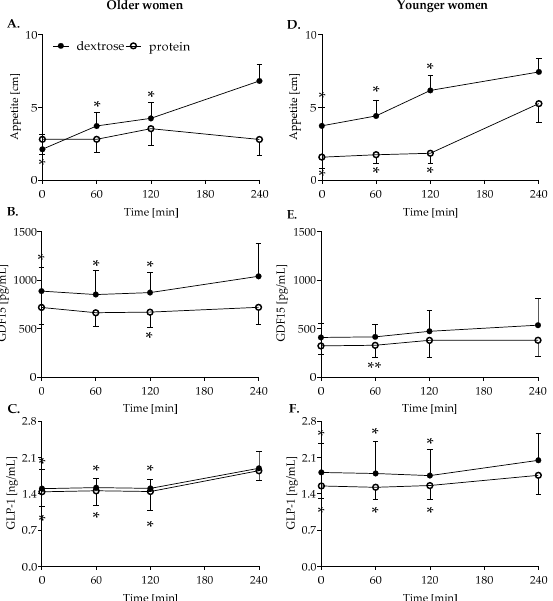
Figure 2. Postprandial appetite ( A ), GDF15 ( B ) and GLP-1 ( C ) concentrations in older and younger women (( D , E , F ), respectively) following dextrose (closed circles) or protein (open circles) ingestion. GLP-1 concentrations were logarithmized for normalization. Repeated measures ANOVA, data are shown as mean ± SD. * indicates significant difference to 240 min, ** to 120 min, separately for both test meals. Postprandial changes of GLP-1 concentrations were calculated using log-transformed values but are shown as untransformed values for better visualization. n = 10 per group; n = 9 in younger high-protein group. Closed circles represent older women, open circles younger